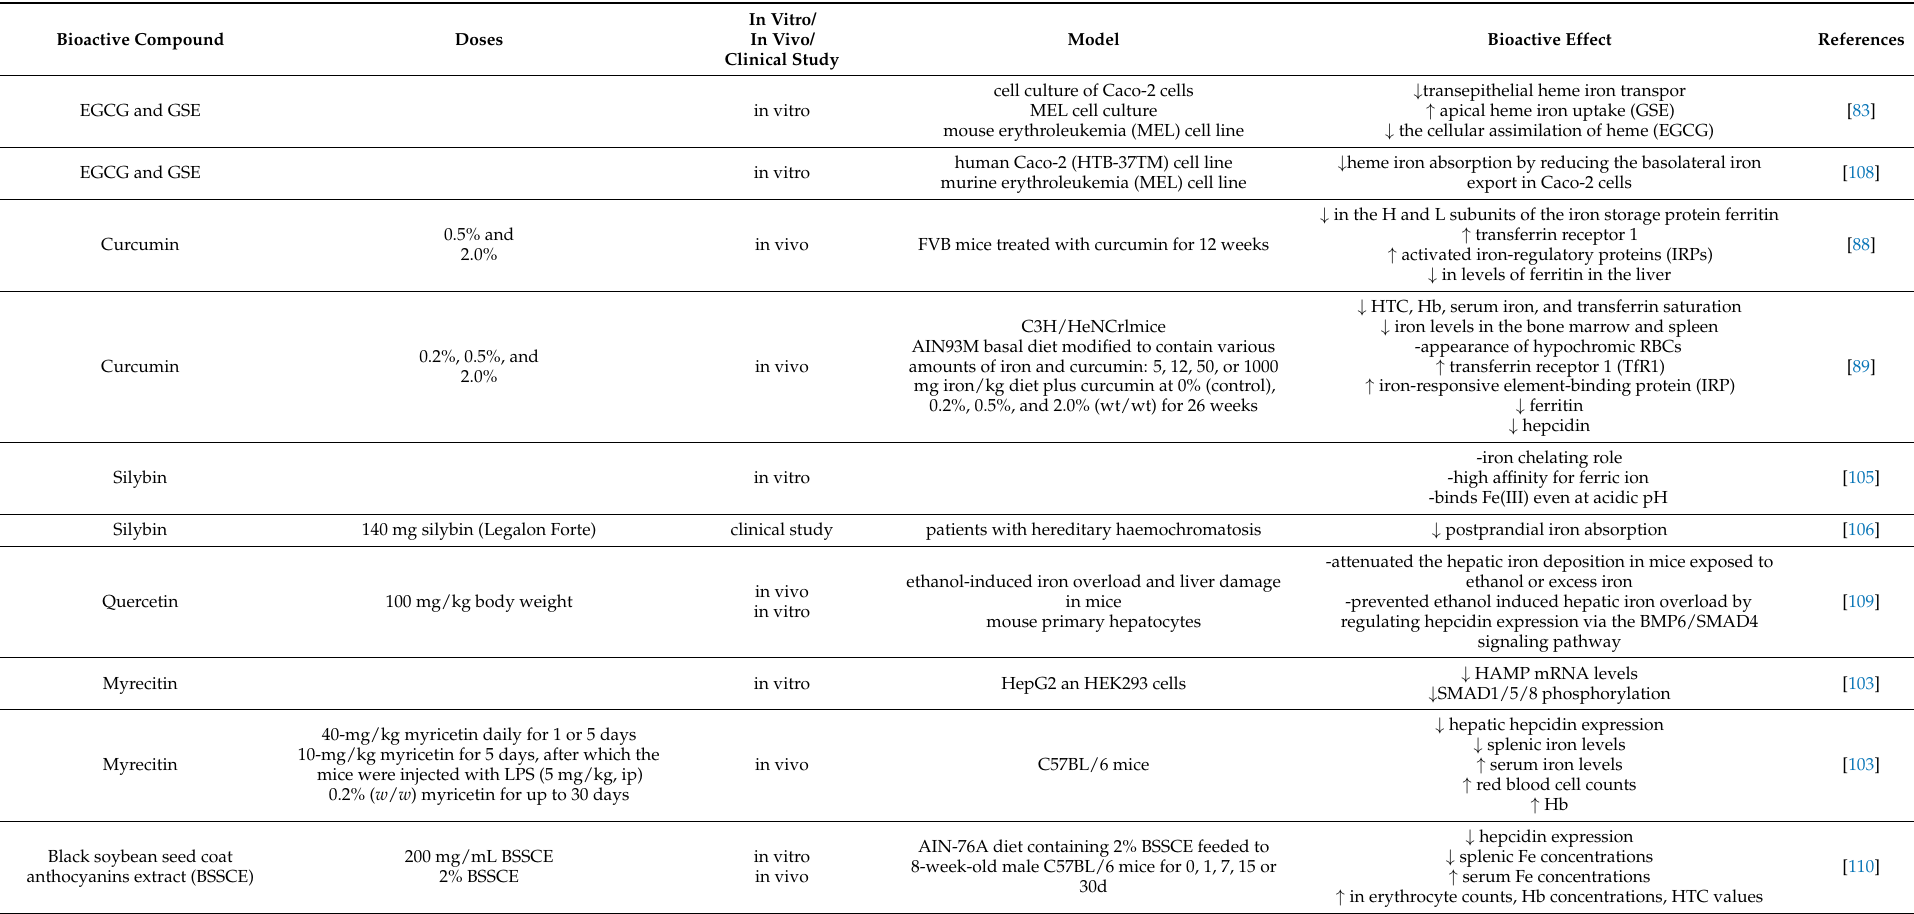
Table 2. Pharmacological effects of the natural antioxidants in iron chelation